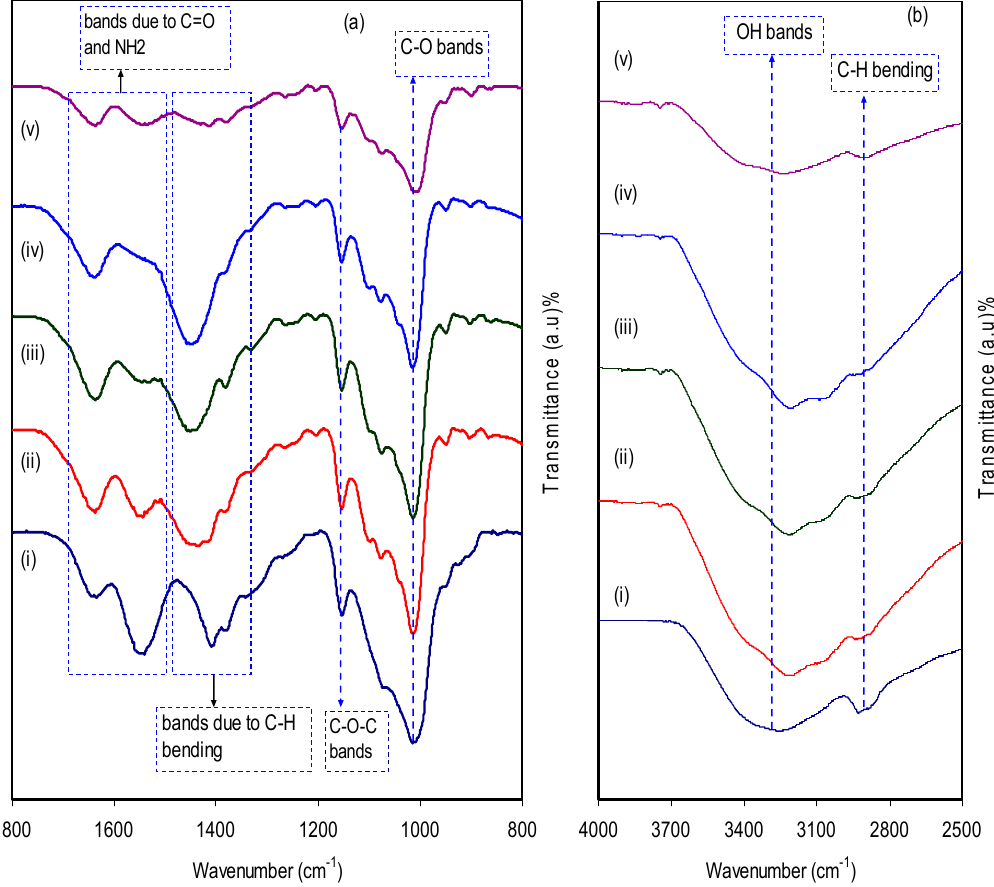
Figure 3. Fourier transform infrared (FTIR) spectra of (i) CS:Dextran (pure blend film), (ii) CSDX 1, (iii) CSDX 2, (iv) CSDX 3, and (v) CSDX 4 in the region ( a ) 800 cm − 1 to 1800 cm − 1 , and ( b ) 2500 cm − 1 to 4000 cm − 1 .